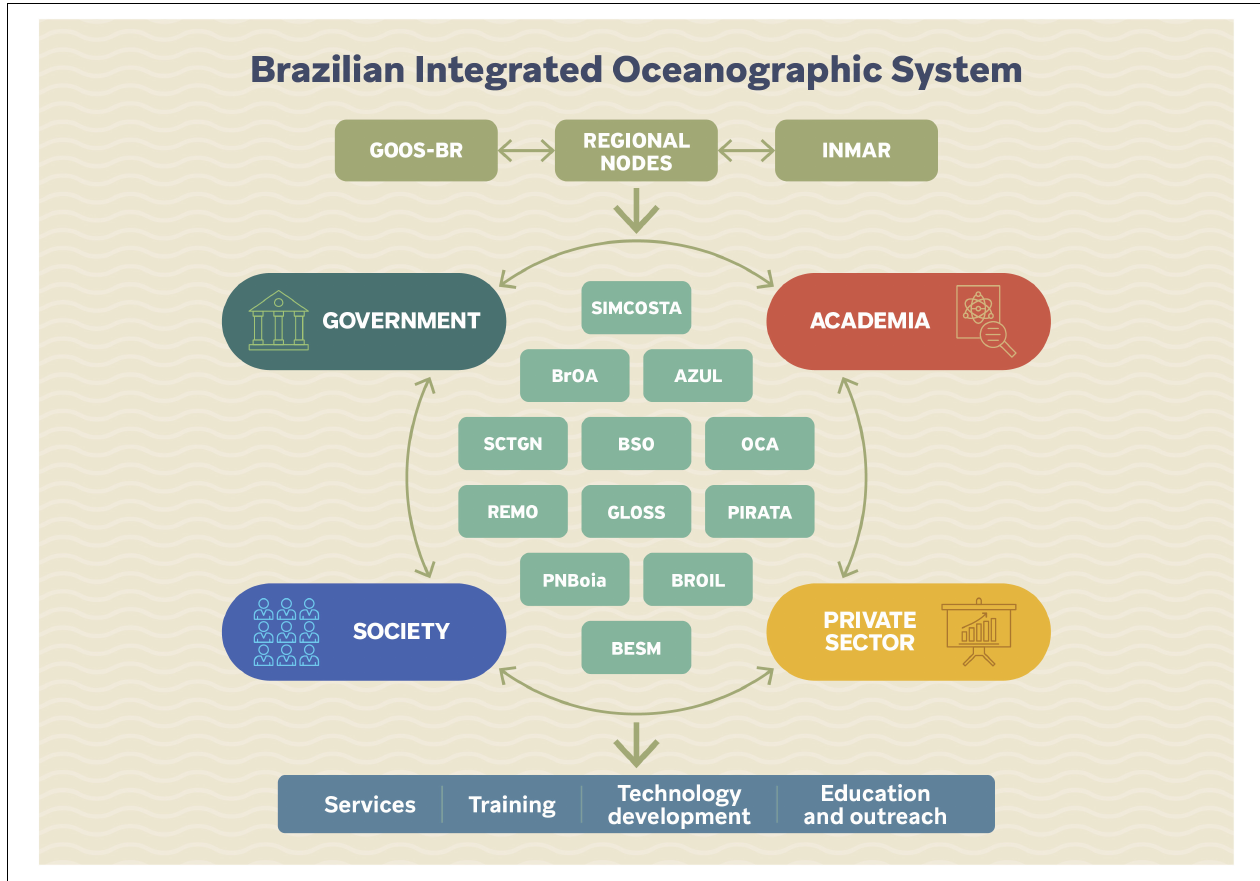
FIGURE 8 | Proposal for a concept structure of a Brazilian Integrated Oceanographic System, integrating observing and modeling systems in different scales, such as the initiatives described herein, but also open to other initiatives linked to research projects and other actions not included in this paper.